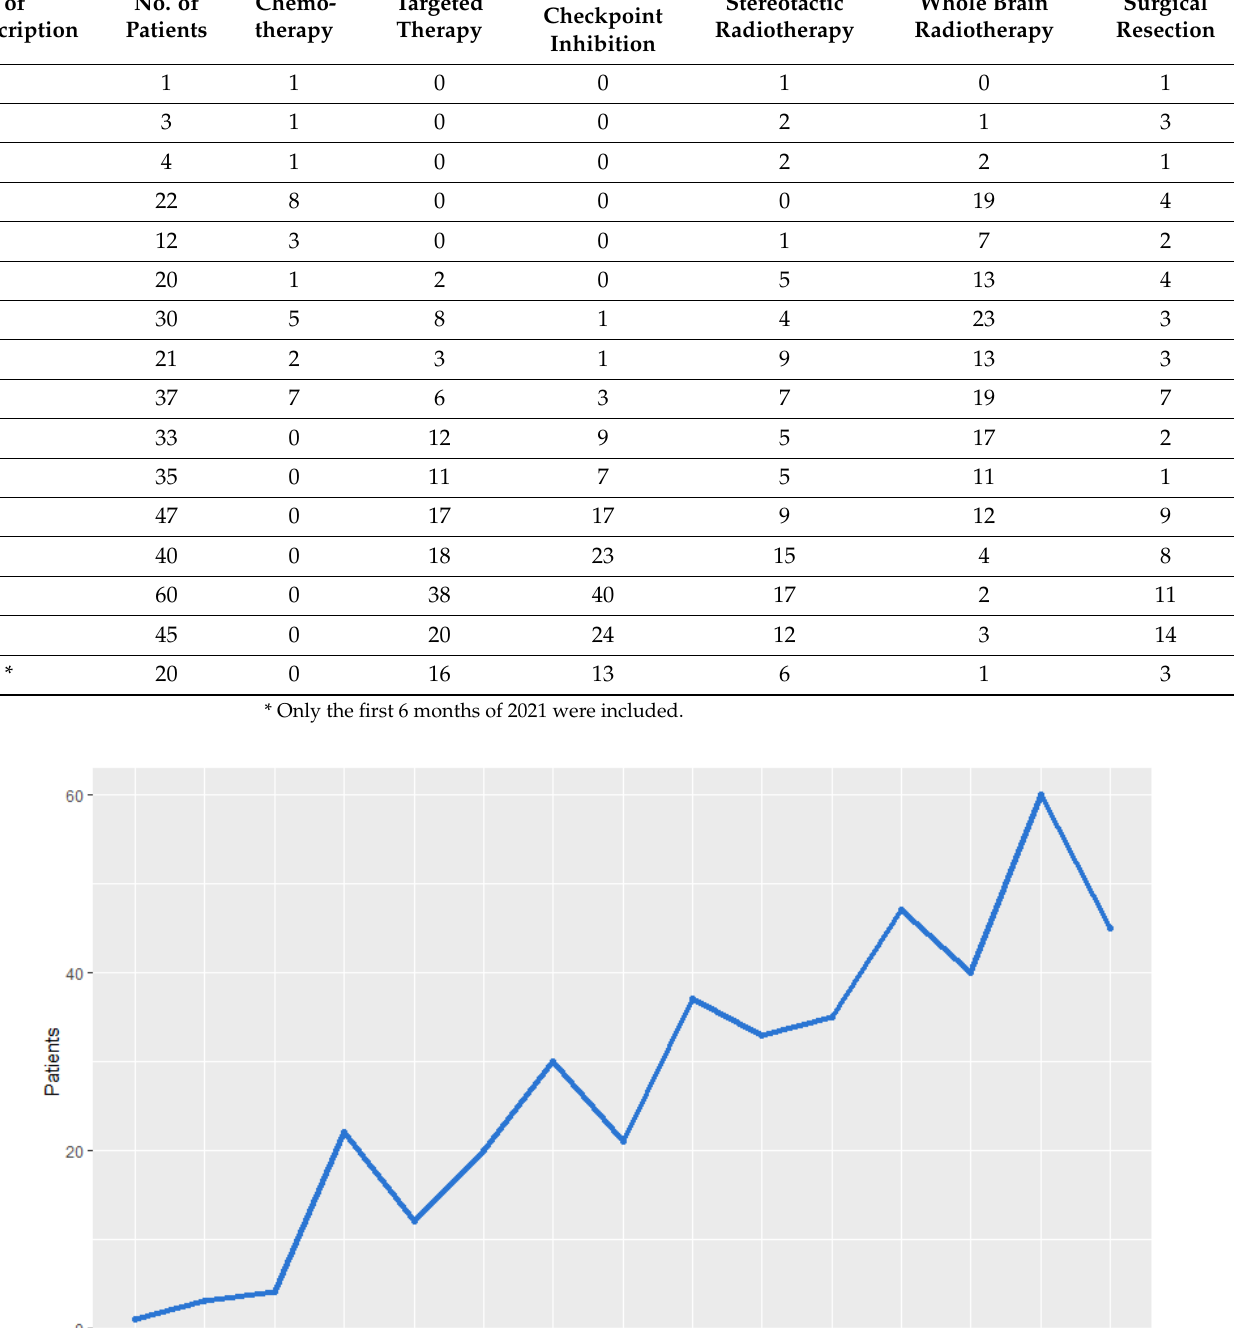
Table A1. Yearly incidence of patients with newly diagnosed melanoma brain metastasis (MBM) referred to the Erasmus MC, and yearly treatment prescriptions (at any time after MBM diagnosis).